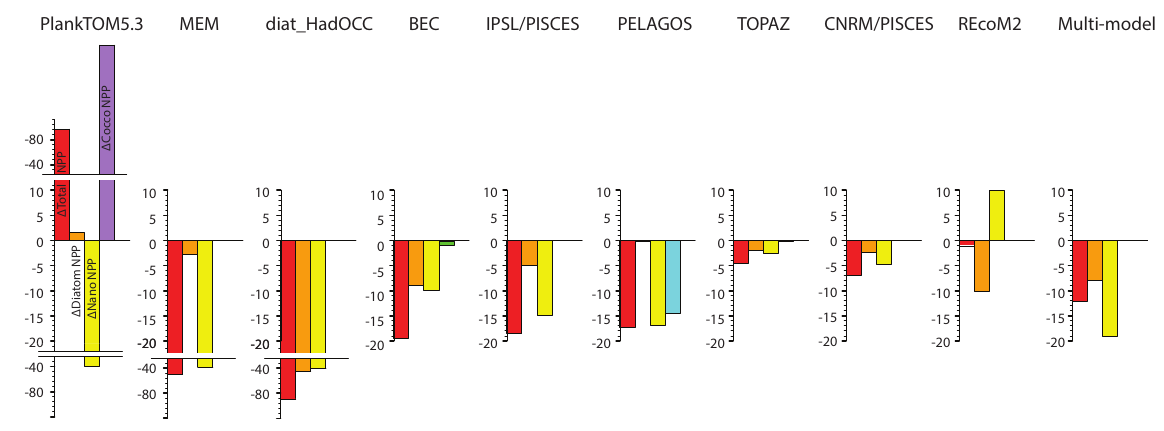
Figure 9. Decomposition of annual mean area-averaged low-latitude surface NPP changes between 2012–2032 and 2080–2100 (red bar, inmolCm − 2 yr − 1 ) into change in nanophytoplankton (yellow) and diatom (orange) surface NPP. Changes in diazotrophs (green) and pico- phytoplankton (light blue) have been included in the bar indicating nanophytoplankton changes for the models that simulate these functional types. For TOPAZ, changes in large non-diatom phytoplankton (dark blue) are included in the bar indicating diatom changes. Changes in coccolithophore NPP are shown in purple. Note the change in scale between the first three plots (models with large surface NPP changes) and the remaining six plots. While for diat-HadOCC, BEC, IPSL–PISCES, CNRM–PISCES, REcoM2 and TOPAZ the surface NPP of the PFTs was included in the model output, we show recalculated values for PlankTOM5.3, MEM and PELAGOS.